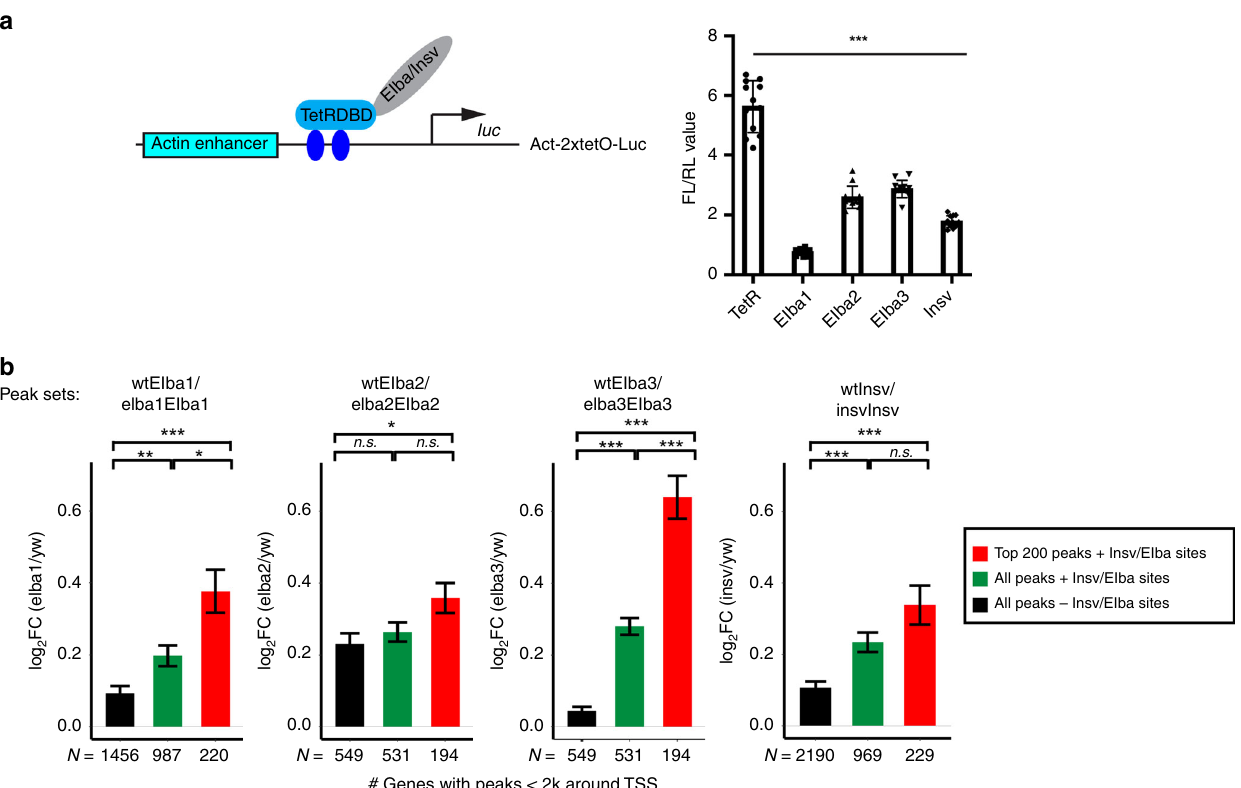
Fig. 4 Elba and Insv repress target gene expression. a Luciferase reporter assays with the TetR-DNA-binding domain (DBD) fusion proteins. The Elba and Insv proteins were fused with the TetR-DBD and thus brought to the 2 × Tet operator sites in the luciferase reporter. The values of fi re fl y/renilla luciferase ratio are plotted and represent the average from three biological replicates with each biological replicate having four technical replicates. So 12 values are included for each condition ( n = 12), and error bars represent S.D. p -value is calculated using a Student ’ s t test, two-tailed, type 1. *** p < 0.001. Source data are available in a Source Data fi le. b The four bar plots show log 2 fold change of RNA level of target genes in the mutant versus wt based on RNA-seq data. For each factor, the top 200 bound genes that contain the Elba/Insv motifs (red) were more upregulated than all the target genes with the Insv/Elba motifs (green) and the target genes without the Insv/Elba motifs (black). Pairwise statistical signi fi cance among the three sets were calculated by two-tailed t tests, and p- values were adjusted by the Bonferroni multiple testing correction method (* p < 0.05, ** p < 0.01, *** p < 0.001, n.s. not signi fi